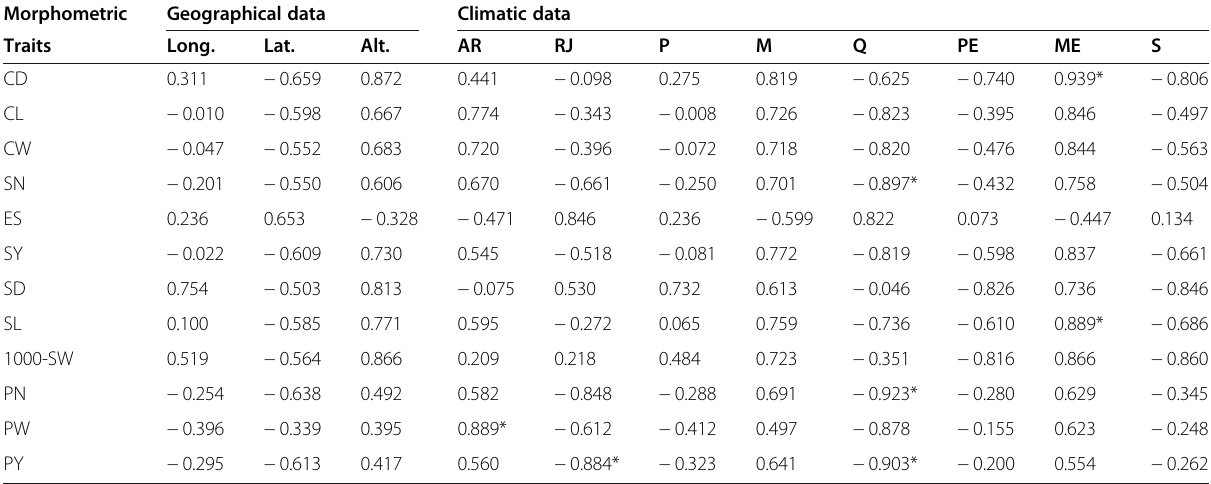
Table 7 Correlation coefficients ( r values) of cone, seed, pine nut, geographical, and climatic variables of the five P . pinea natural populations across Turkey Morphometric Geographical data Climatic data Traits Long. Lat.